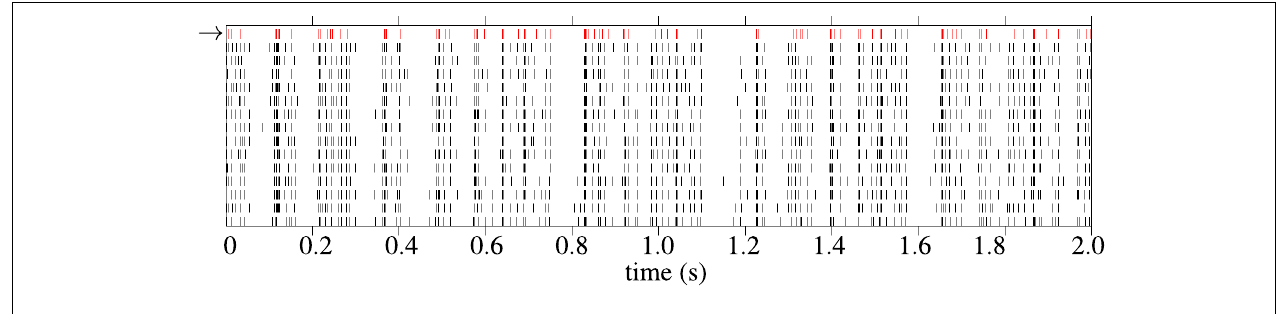
spike trains are individual trials from experimental recordings The cell is “pupi01414_10,” taken from the CRCNS aa-2 data set (Theunissen et al.,